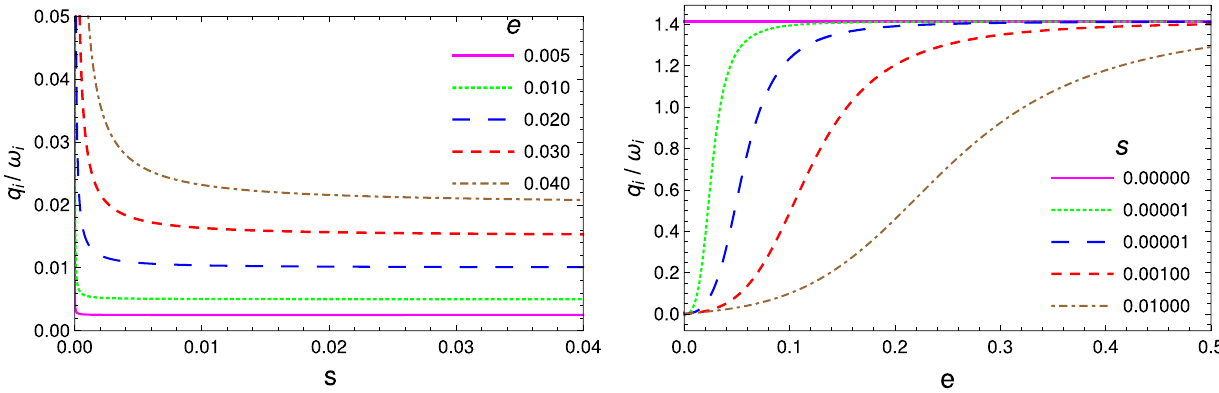
Fig. 2 (Left) Plot of the maximum charge-mass ratio with s for different values of the electric charge e with M ADM = 1. (Right) Plot of the maximum charge-mass ratio with e for different values of the scalar charge s with M ADM =